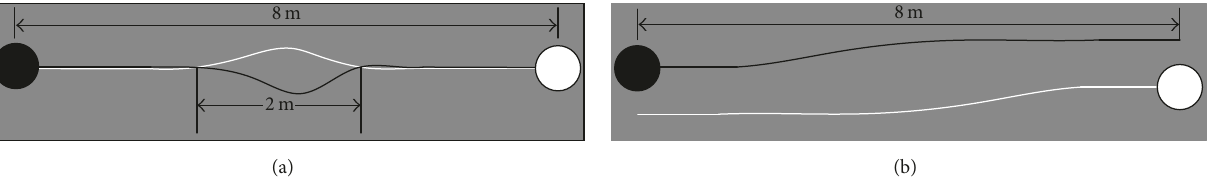
Figure 12: The moving trajectory by the improved model, which considers the moving preference. (a) is the “face-to-face” case, where 𝑙 𝑖𝑗 = 0 m, and (b) is the “brush past” case, where 𝑙 = −0.3 m. 𝑖𝑗